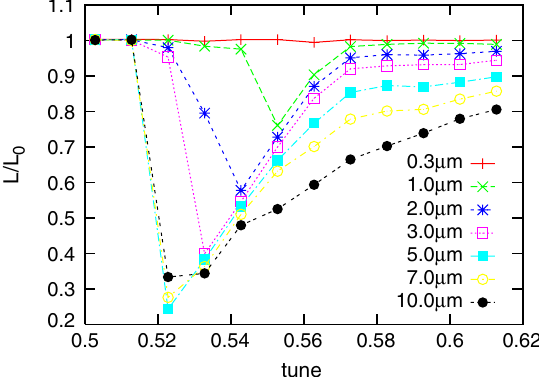
FIG. 5. Simulated relative luminosity versus frequency of the various excitation amplitudes.